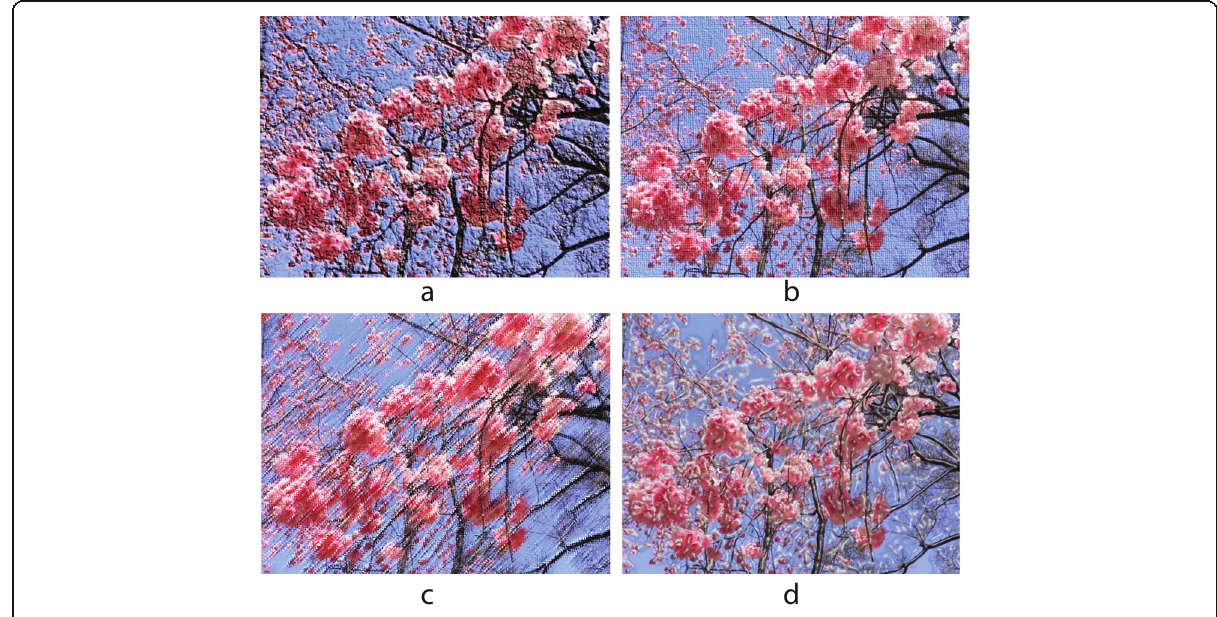
Fig. 9 Unrealistic art processing effect diagram. a Mask 5 × 5. b Mask 9 × 9. c Mask 15 × 15. d Mask 25 ×